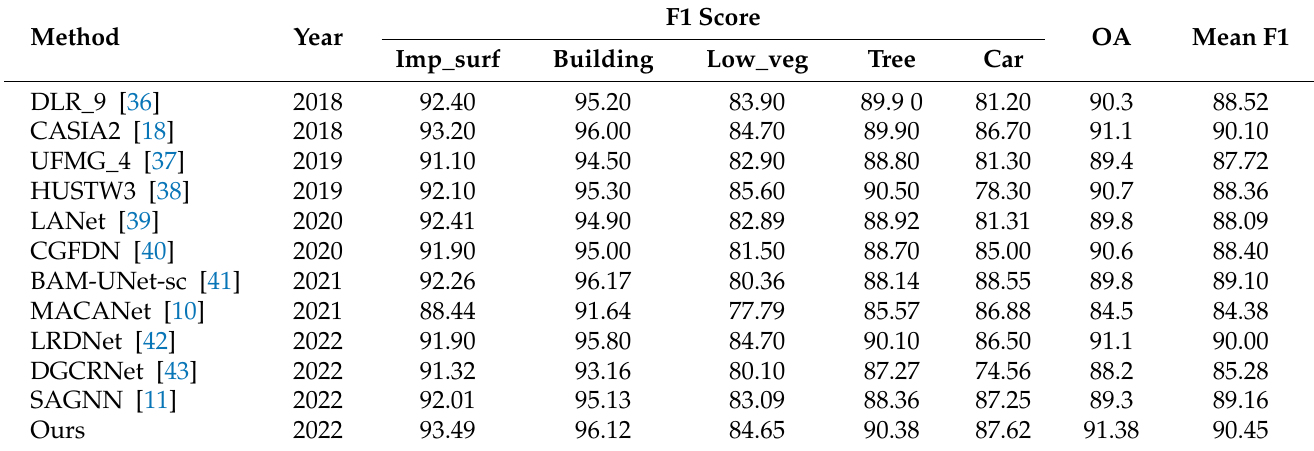
Table 5. Comparisons between the LGNet and other state-of-the-art methods on the Vaihingen